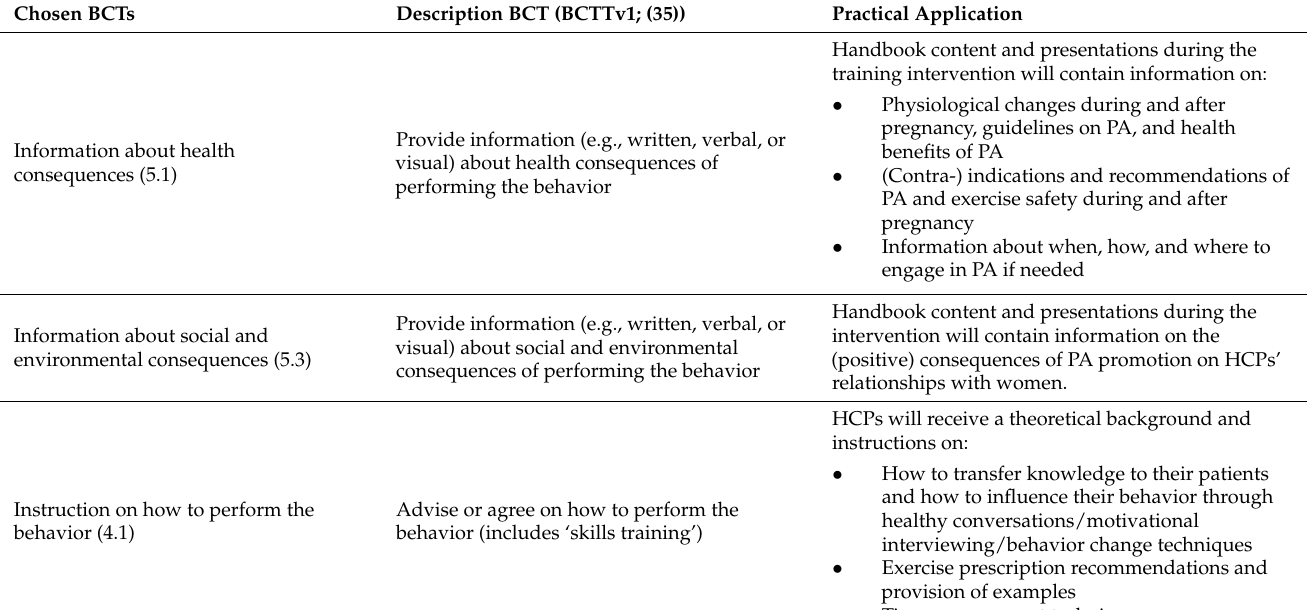
Table 3. Performance objectives with mapped change objectives and respective TDF